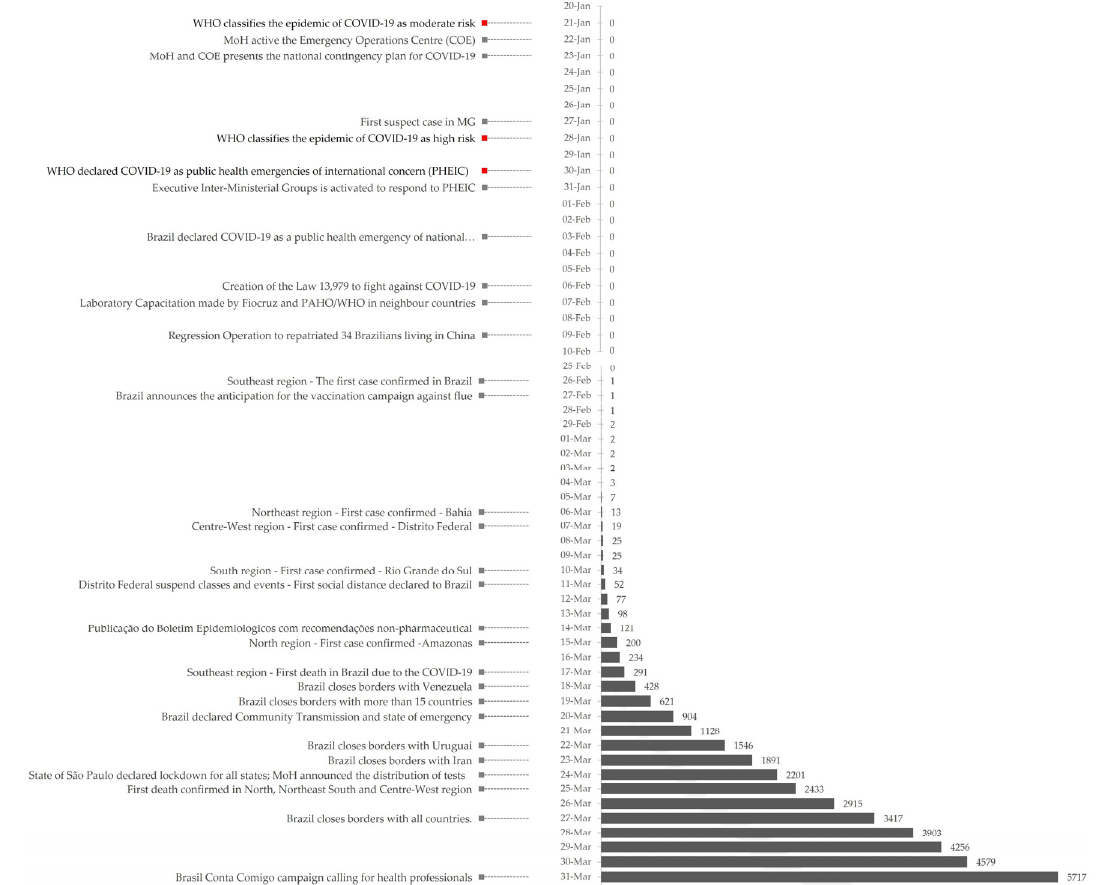
Figure 3. Timeline with measures taken by the Ministry of Health (grey) and the WHO (red) on the left with the evolution of accumulate cases of COVID-19 on the right.